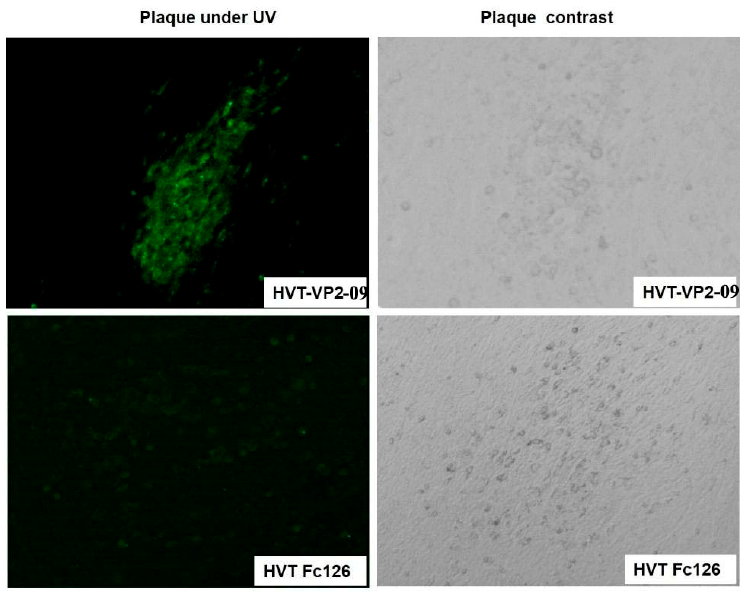
Figure 7. Indirect immunofluorescence assay (IFA). Chicken embryo fibroblast monolayers (80–90% confluent) were infected with HVT-VP2-09 or HVT Fc-126. The wells were overlaid with polyclonal rabbit antibodies produced by vaccination with the IBDV VP2 protein (1:200) and incu- bated at 37 °C for 1 h. The wells were incubated with anti-rabbit IgG-FITC antibody produced in goat (1:1000) (Abcam) at 37 °C for 1 h. Fluorescent plaques infected with recombinant HVT-VP2-09 were visible by inversion fluorescence microscopy; however, nonfluorescent plaques infected with recombinant HVT Fc-126 were visible by inversion fluorescence microscopy.